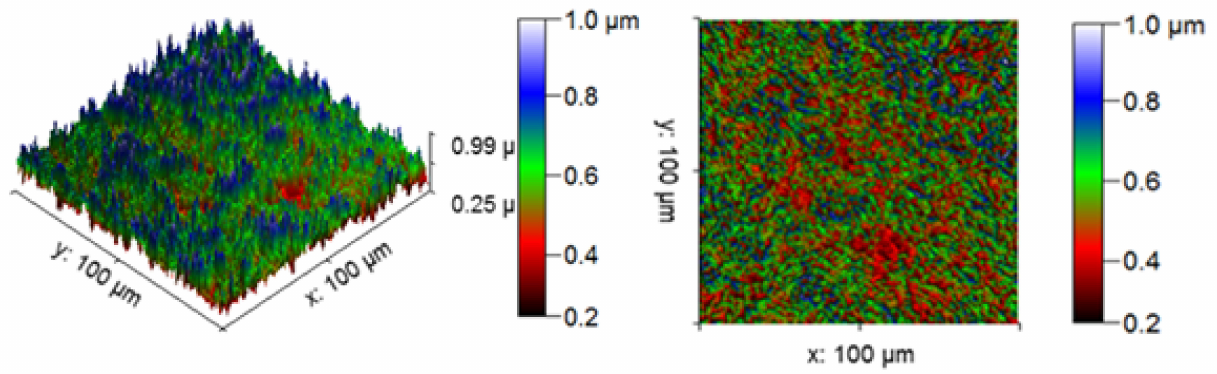
Figure 28. Corrosion test specimen (minimum